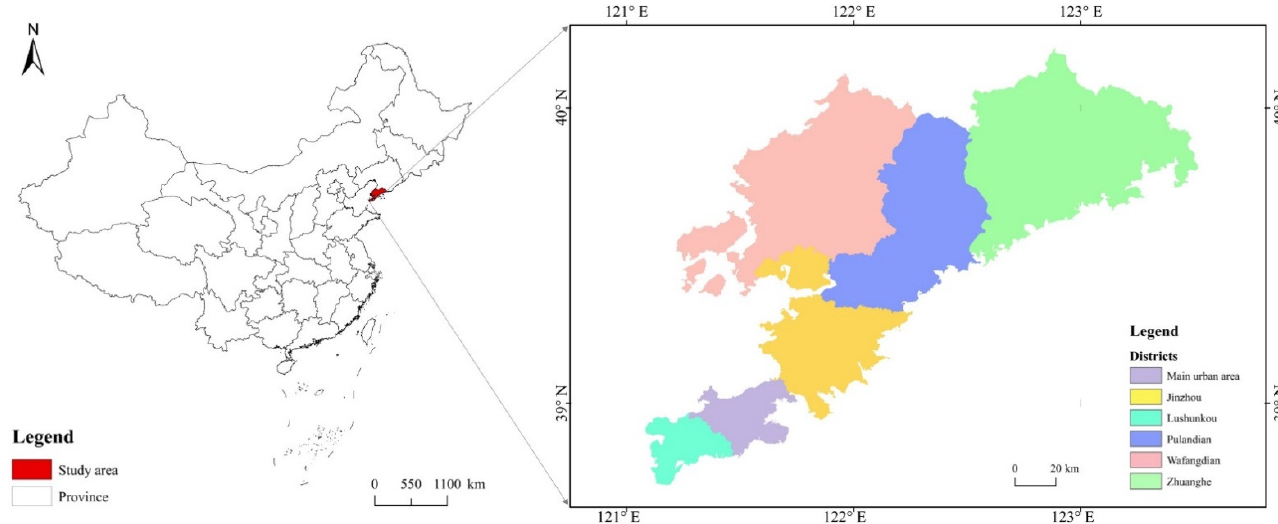
Table 1. Parameters of Landsat TM